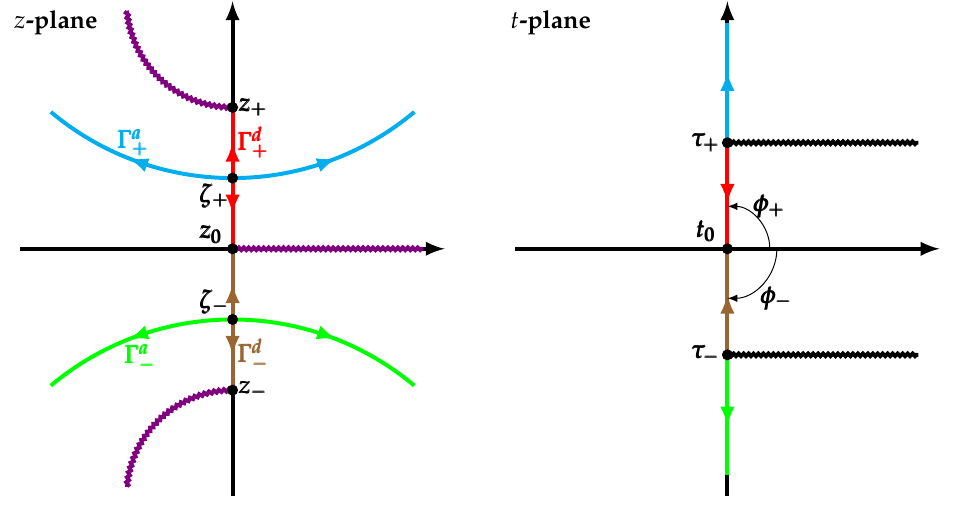
Figure 19. Cuts, ascent paths and descent paths.